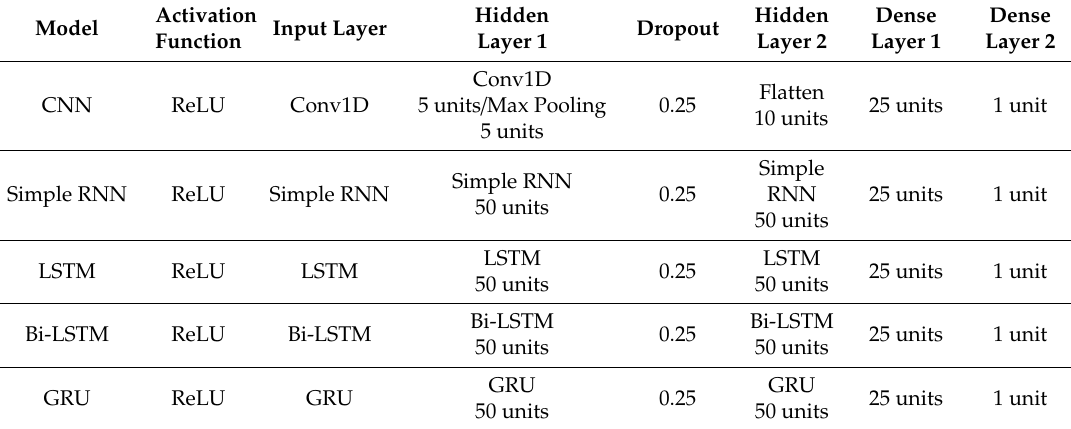
Table 3. Composition and hyperparameters of